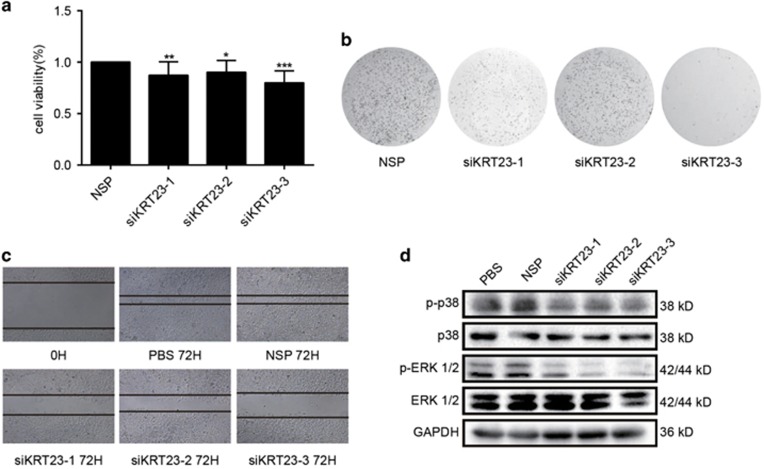
Knockdown of KRT23 inhibited the proliferative capacity and migration of LoVo CRC cells. (a) Cell viability was analyzed by MTT in LoVo cells that were transfected with siKRT23 or NSP for 48 h. (b) Colony formation assay of LoVo cells transfected with siKRT23 or NSP two times a week for 2 weeks. (c) Cell migration was analyzed by a wound-healing assay. LoVo cells were seeded in 6-well plates and grown to full confluence (50 ×). (d) The phosphorylated and total ERK and p38 levels in LoVo cells transfected with siKRT23 were detected by western blot assay using antibodies against p-p38, p38, p-ERK and ERK (*P<0.05, **P<0.01 and ***P<0.001)